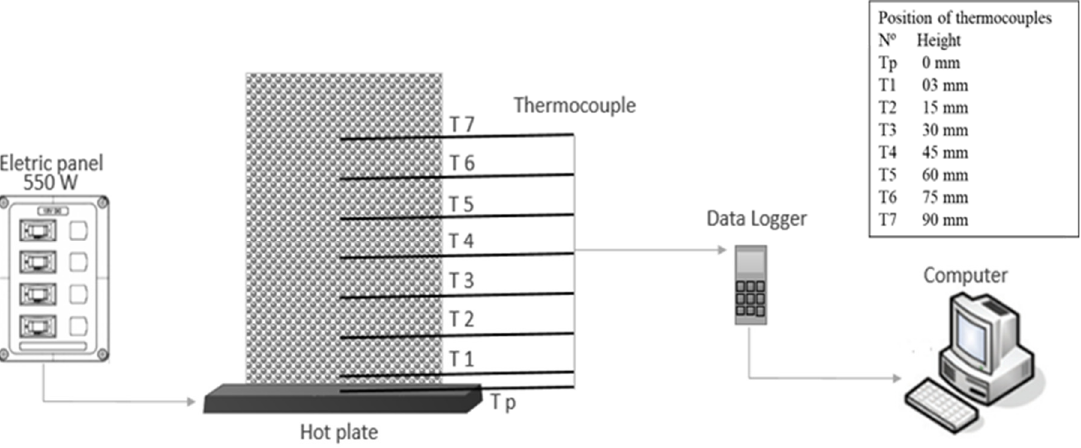
Figure 2. Schematic of the experimental setup.